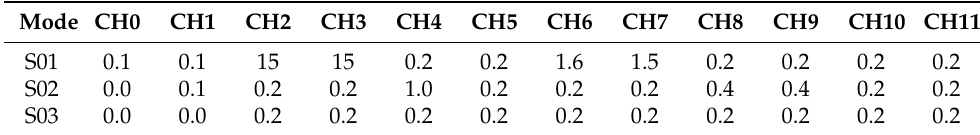
Table 4. f / f n in frequency domain at different monitoring